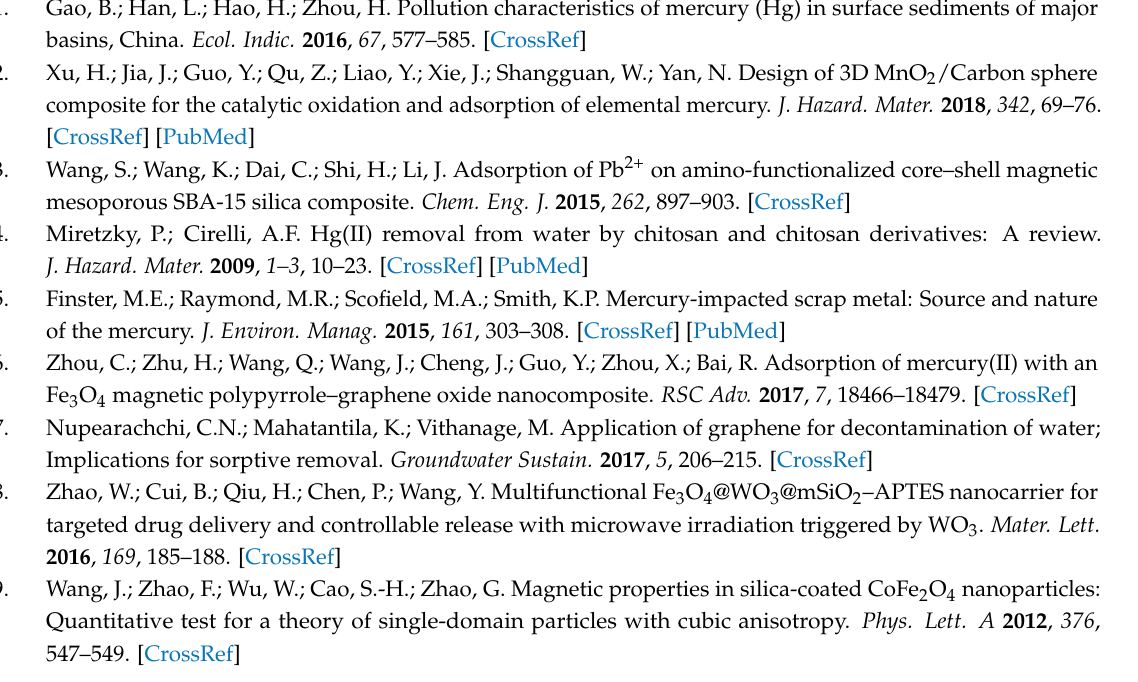
Figure S1: SEM micrograph with X-ray elemental area scanning of CoFe 2 O 4 @SiO 2 (a); Elemental mapping recorded from one